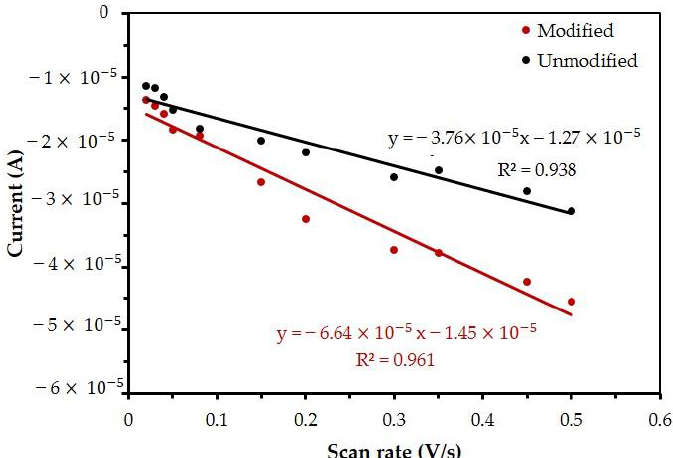
Figure 8. Measurements of cathodic peak current for unmodified and modified electrodes as a func- tion of the applied scan rate . The measurements were obtained using a solution of 5 mM K 3 [ Fe ( CN ) 6 ] and 0 . 1 M KCl . This graph is used for the calculation of surface coverage .